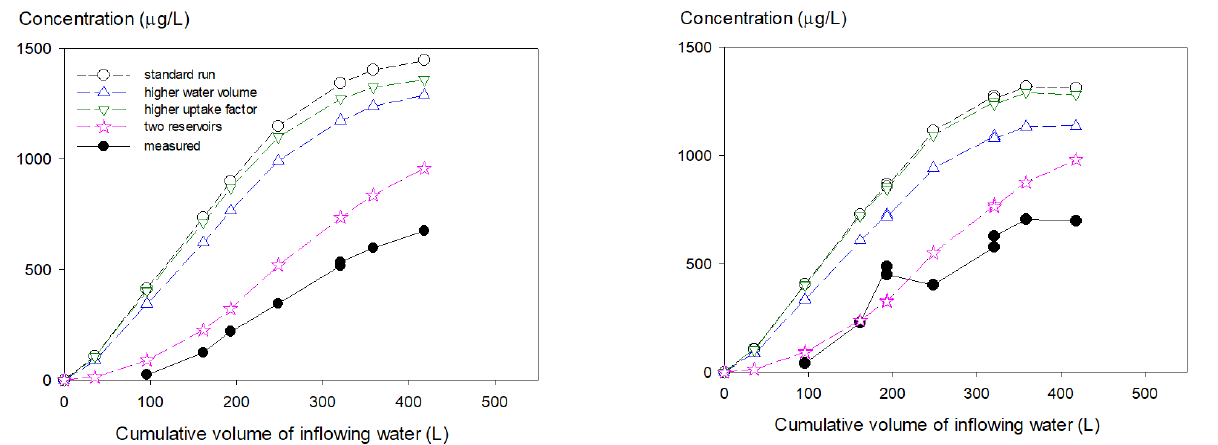
Figure 8. Measured and simulated concentrations of imidacloprid ( left ) and pymetrozine ( right ) in the used-water tank as a function of the cumulative water volume flowing into this tank. The standard run was based on first estimates of the parameters (also shown in Figure 7); the run with the higher water volume assumed a 25% increase in the volume of water in the cultivation reservoir; the run with higher uptake factor assumed a 25% increase in the TSCF; for the run with the two reservoirs, the cultivation reservoir was divided into two reservoirs of equal size with plant uptake only from the first reservoir. Both measured and simulated concentrations of pymetrozine were multiplied by 2.94/2.25 to account for the di ff erence in dosage between imidacloprid and pymetrozine.